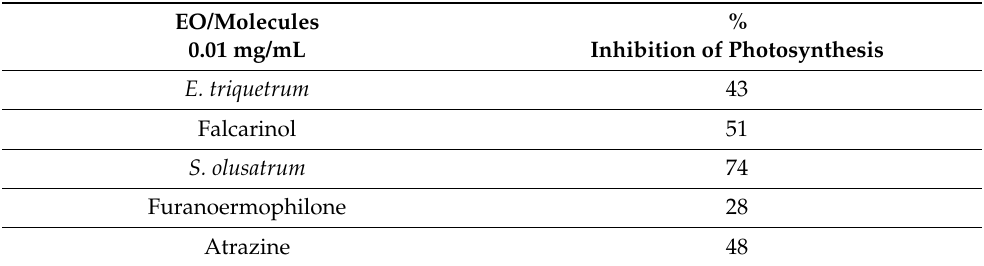
Table 5. Thylakoid test results of E. triquetrum and S. olusatrum essential oils and the major compounds.